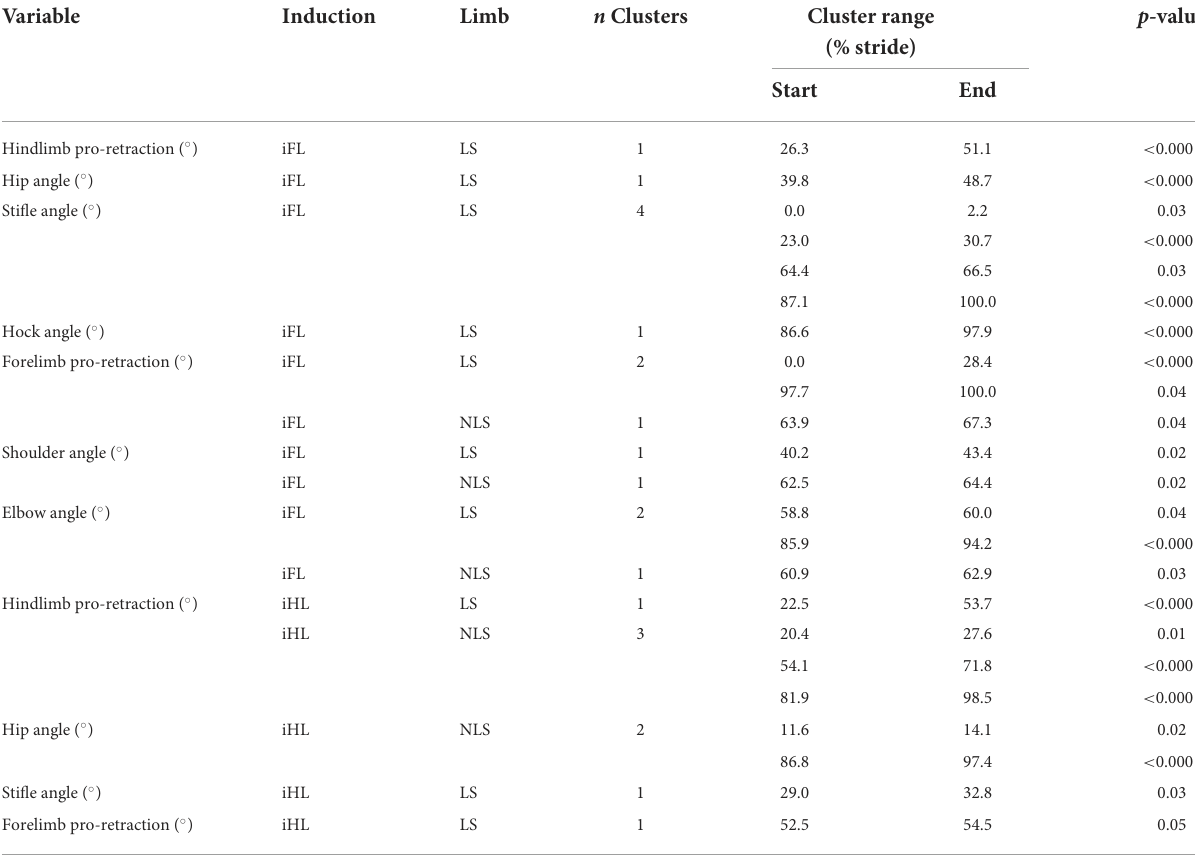
TABLE 2 Results from SPM analysis of kinematic data, presenting information on the data clusters that exceeded the critical thresholds for significance between baseline and induced lameness (iFL, iHL) conditions.